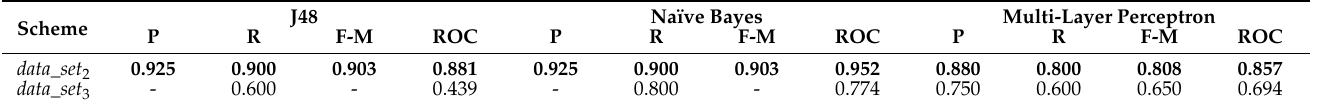
Table 12. Comparison of the two schemes with J48, Naïve Bayes, and Multi-layer Perceptron.